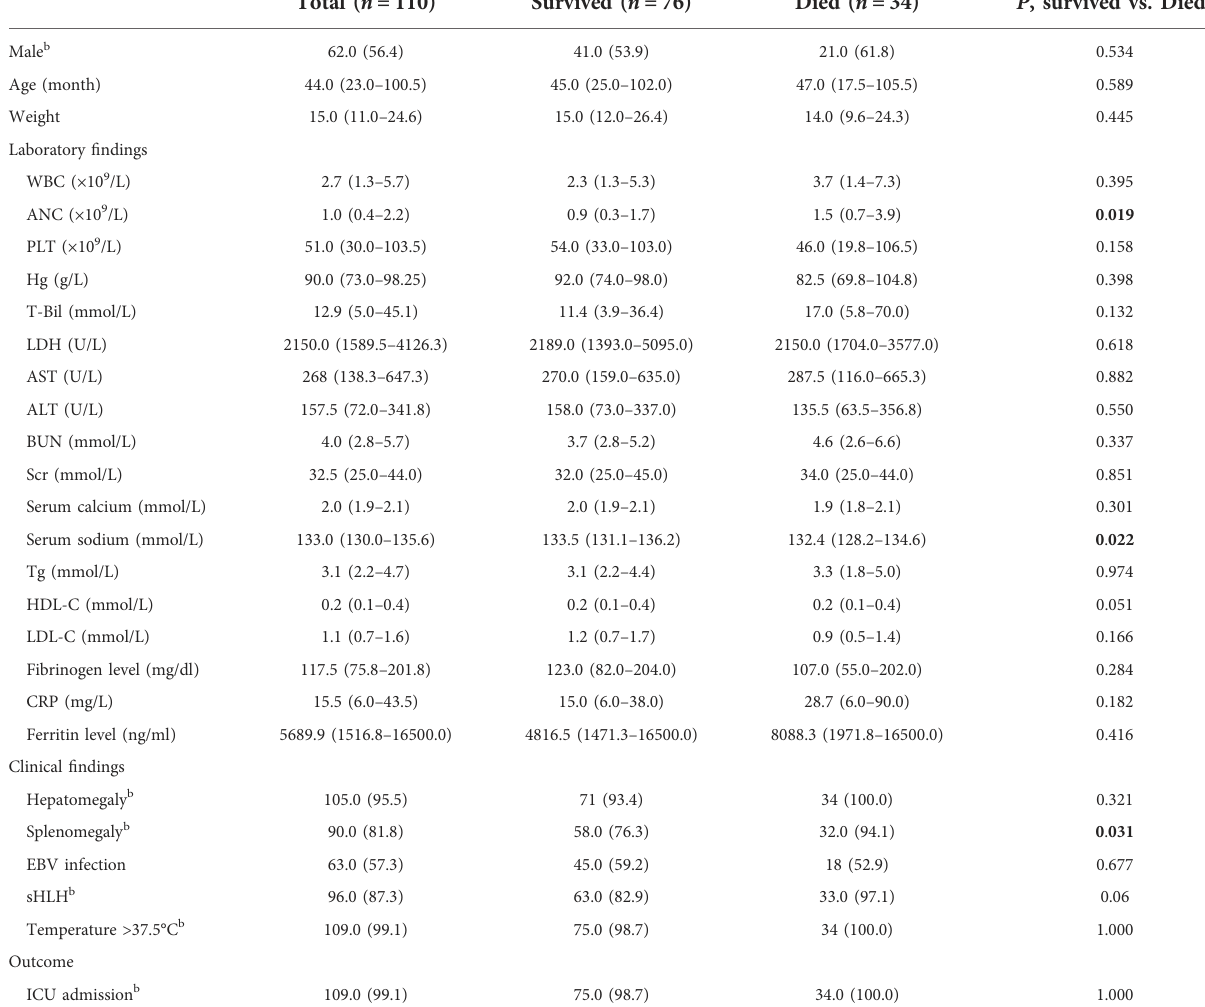
TABLE 1 Demographic and clinical characteristics at presentation of 110 HLH patients according to survival